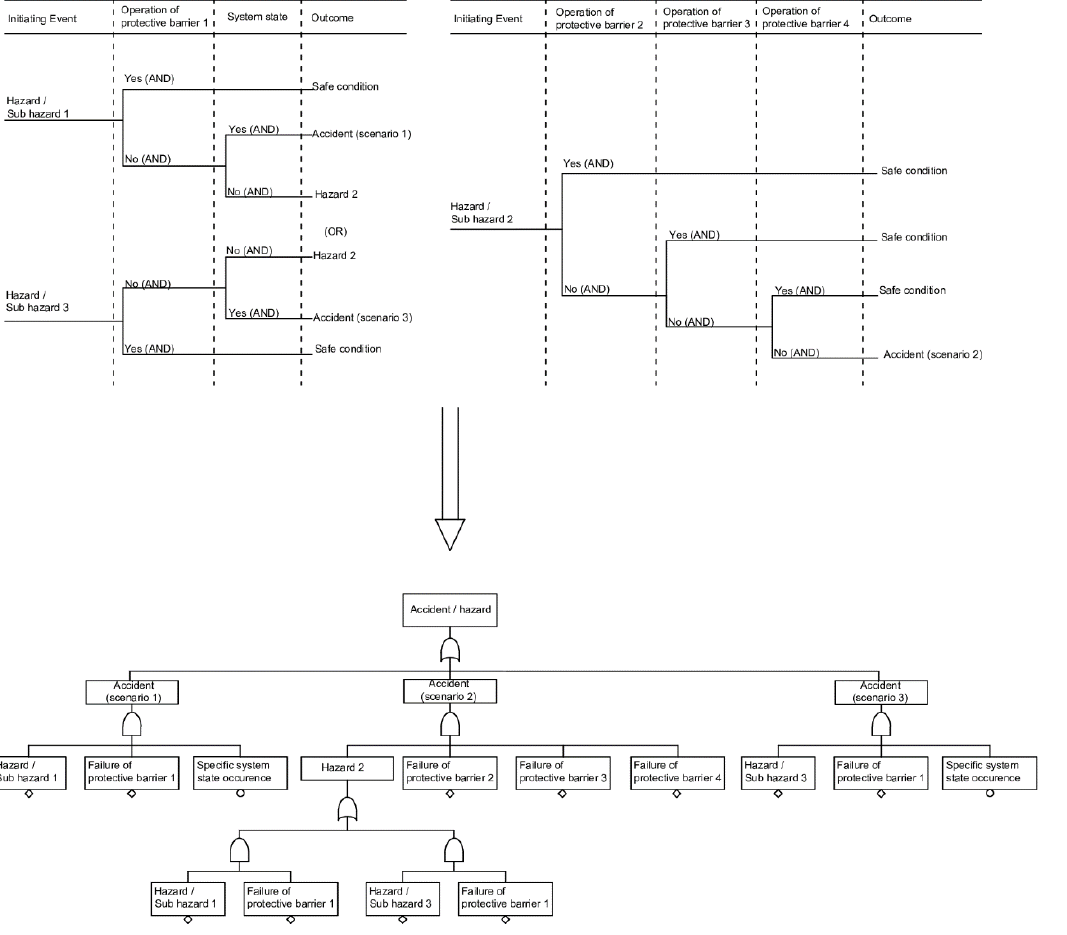
Figure 4. “Event Trees” transformation into a Fault Tree.